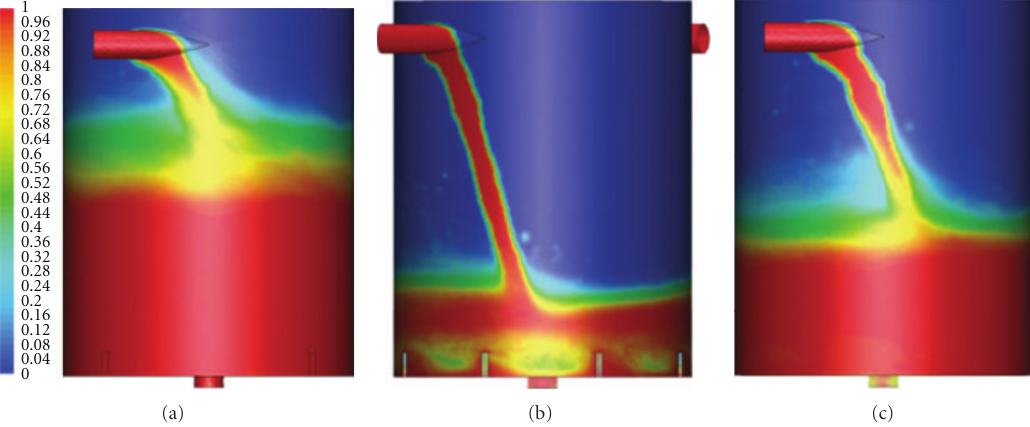
Figure 8: Time-averaged water volume fractions in the annular region from CFD for the 4-vane (a) 8-vane (b) and curved vane (c) geo- metries